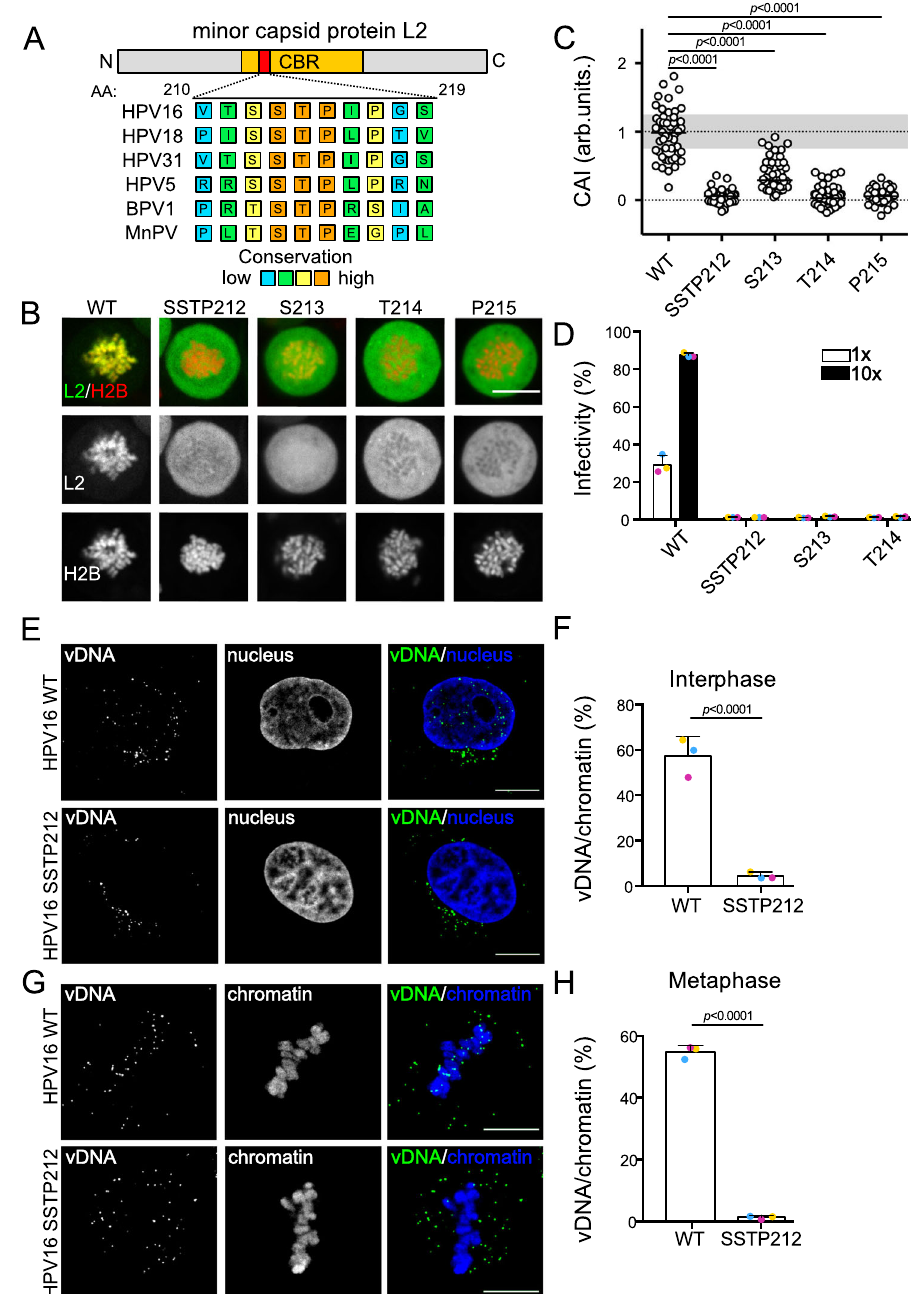
Fig. 1 | A highly conserved SSTP motif on HPV16-L2 is essential for the chro- mosomal association during mitosis. A Alignment of minor capsid protein L2sequencesfortheindicatedhumanandanimalPVs(UniProtKBP03107,P06793, P17389, P06918, P03109, and Q84358) wasgenerated using PRALINE (Bawono and Heringa, 2014). B Chromosomal association assay of ectopically expressed wild type and mutant L2-EGFPs in HeLa H2B-mCherry cells during mitosis; images dis- playrepresentativesinglemedialplanesofspinningdiskconfocalmicroscopywith L2-EGFP in green and H2B-mCherry in red as indicated. Scale bar: 10 µ m. C Quanti fi cation of B , displaying the chromosomal association index (CAI) of individualcells(circles),i.e.,theintensityofH2B-mCherry-overlappingEGFPsignal over total intensity 4 . Values were normalized to EGFP alone (0) and L2-GFP (1). 50 cells from three independent experiments were analyzed. D HeLa cells were infected with L2-WT and mutant HPV16 PsVs as indicated. Infectivity was assessed